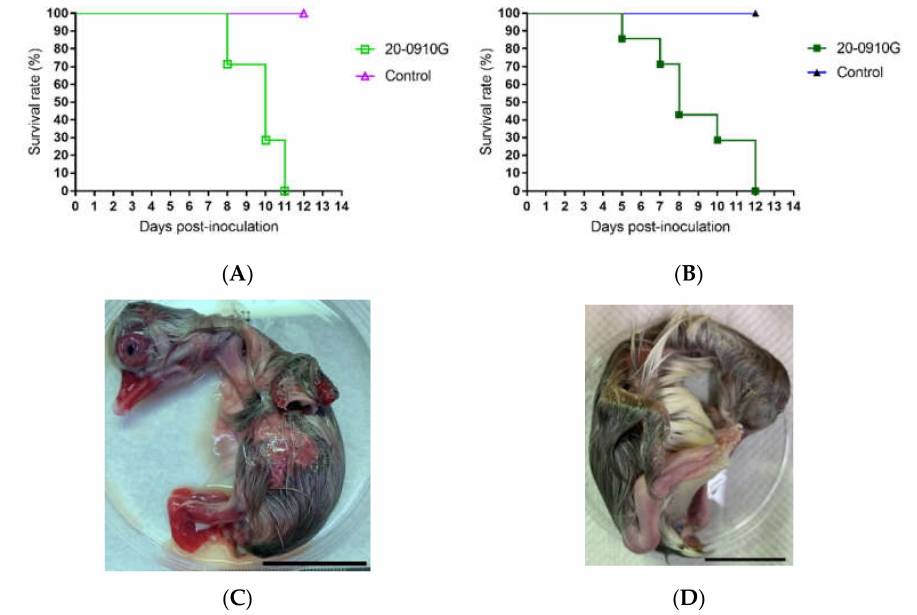
Figure 3. Pathogenicity of 20-0910G in goose embryos and goslings. The embryos were infected with 10 5 EID 50 and 1-day-old goslings were infected with 10 5 ELD 50 of 20-0910G. ( A ) Survival rate of goose embryos; ( B ) survival rate of goslings. All embryos and goslings died within 11 and 12 days post-infection, respectively. ( C ) 20-0910G infected embryos showed stunting and subcutaneous hemorrhage at 8 dpi; ( D ) a 20-day-old goose embryo used as control. The scale bar is 30